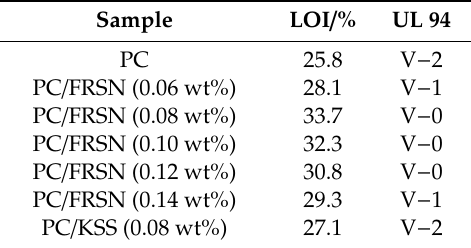
Table 1. Results of the LOI and UL 94 burning tests for PC and PC / FRSN composites.